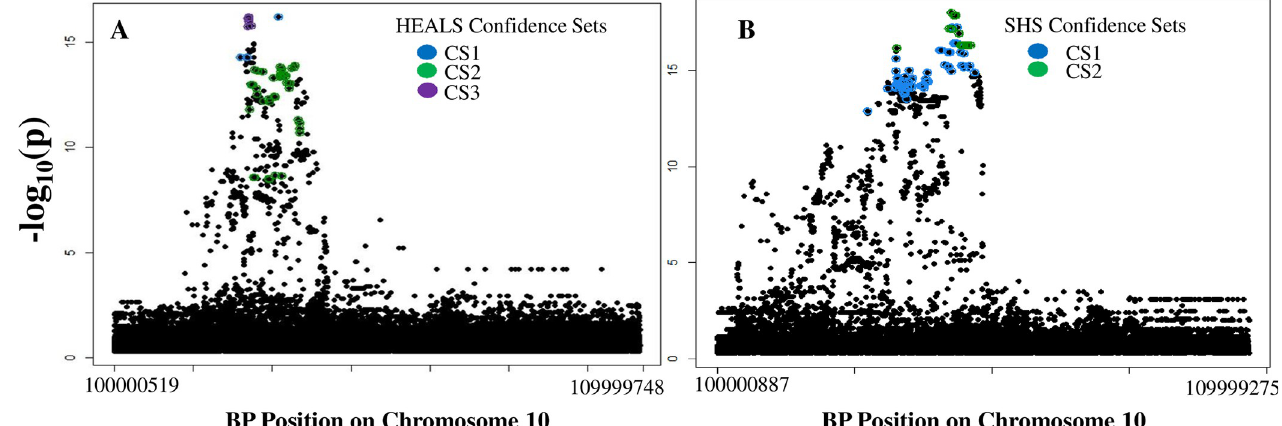
Fig 4. SuSiE Fine-Mapping results. 95% confidence sets for HEALS (A) and SHS (B) are each highlighted in different colors and mapped onto the overall DMA% association results.